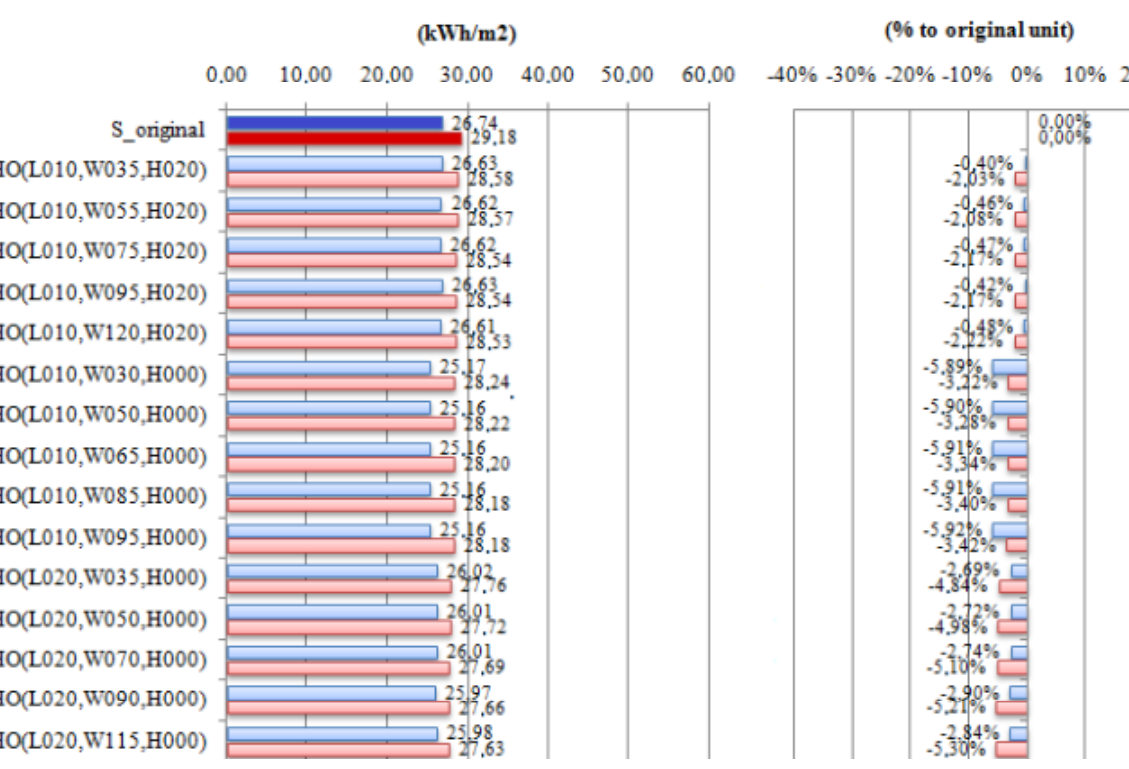
Figure A2. HO Series : Annual thermal